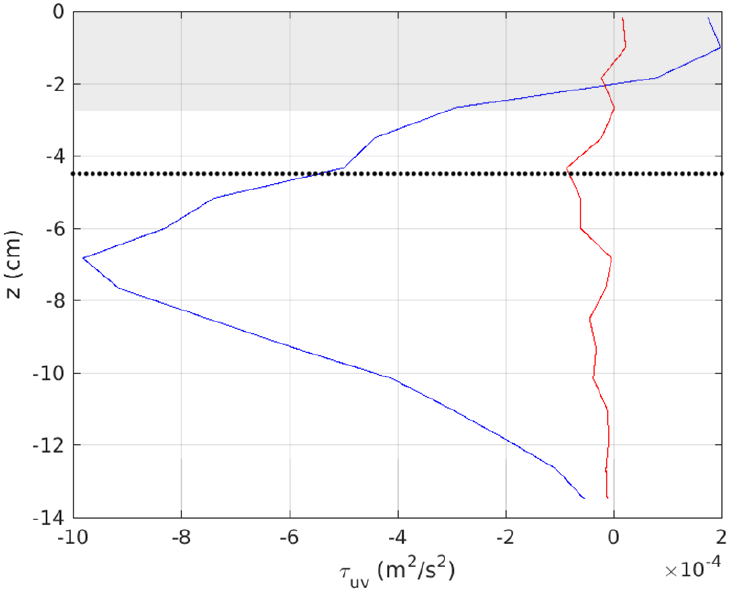
Figure 13. Near-surface Reynolds stress profile for PIV velocity time series at X = 2 cm in trial 18, separated into wave (blue, f < 5 Hz) and turbulent (red, f > 5 Hz) contributions. Note that the direction of positive u velocity in this figure is toward the right, in contrast to Figure 9. Black dotted line represents approximate lowest depth reached by ice–water interface; gray shaded region is depth range in which PIV data were corrupted by ice layer (see text).